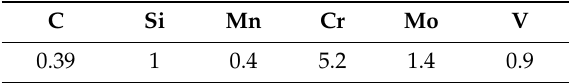
Table 1. Typical chemical analysis (%) of machined material.